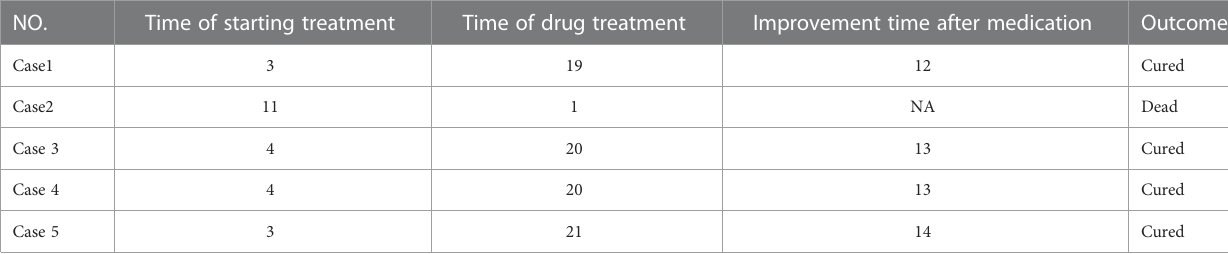
TABLE 3 Treatment and outcome of fi ve